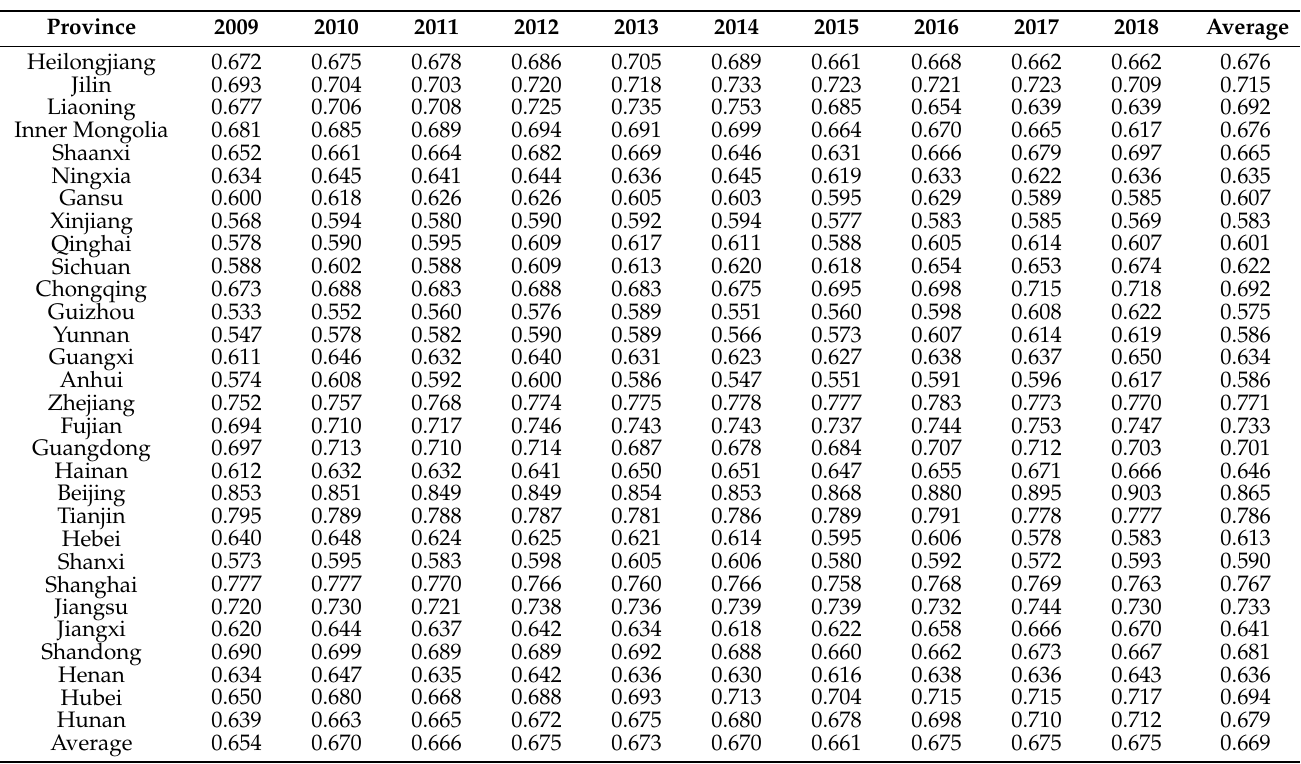
Table 6. The coordination degree in regard to carbon emissions, economic development, and environmental protection.